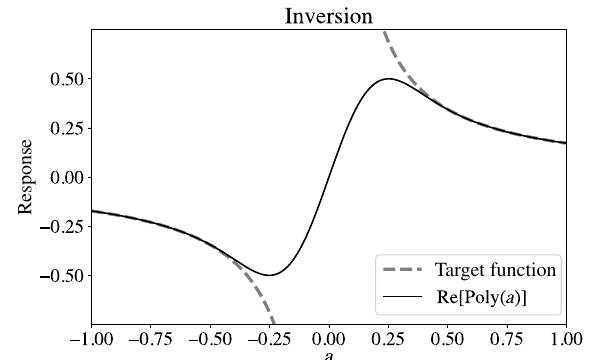
FIG. 23. The response function for the polynomial approxima- tion to the cosine function with t = 5 and (cid:14) = 0.1.